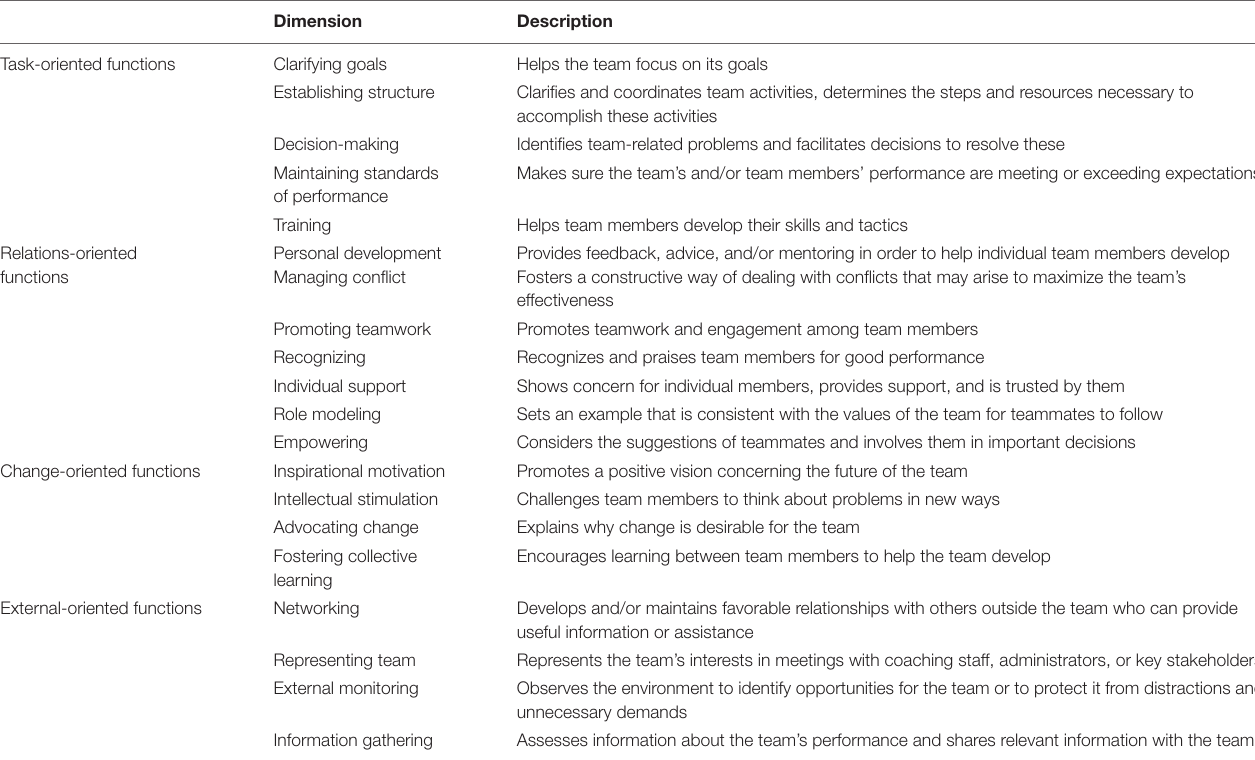
TABLE 1 | A four-dimensional model for the study of athlete leadership.